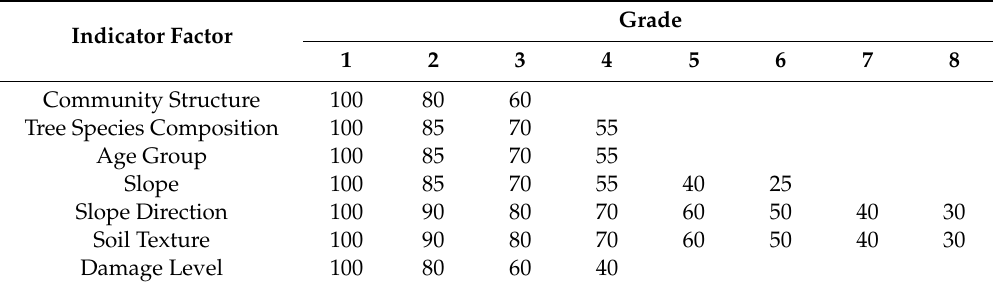
Table 5. Scores of di ff erent grades of the qualitative indicators of the Mount Taishan forest ecosystem health assessment.